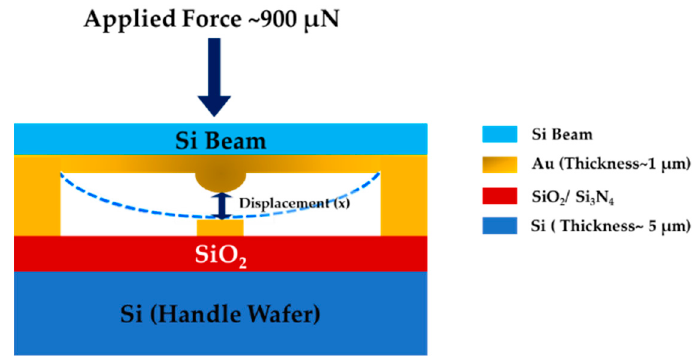
Figure 5 . Schematic illustration of beam motion under available applied force. Figure 5. Schematic illustration of beam motion under available applied force.